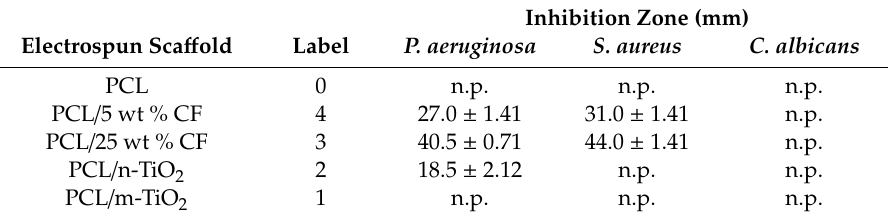
Table 3. Inhibition zone in mm.